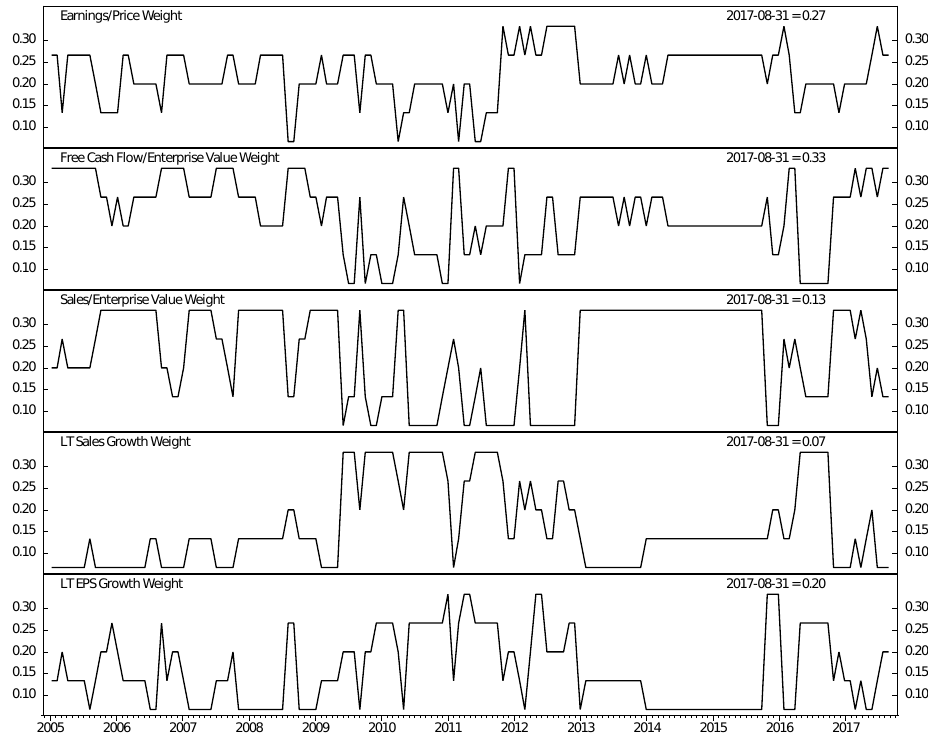
Figure 6. Calculated weights of five global stock factors from January 2005 to September